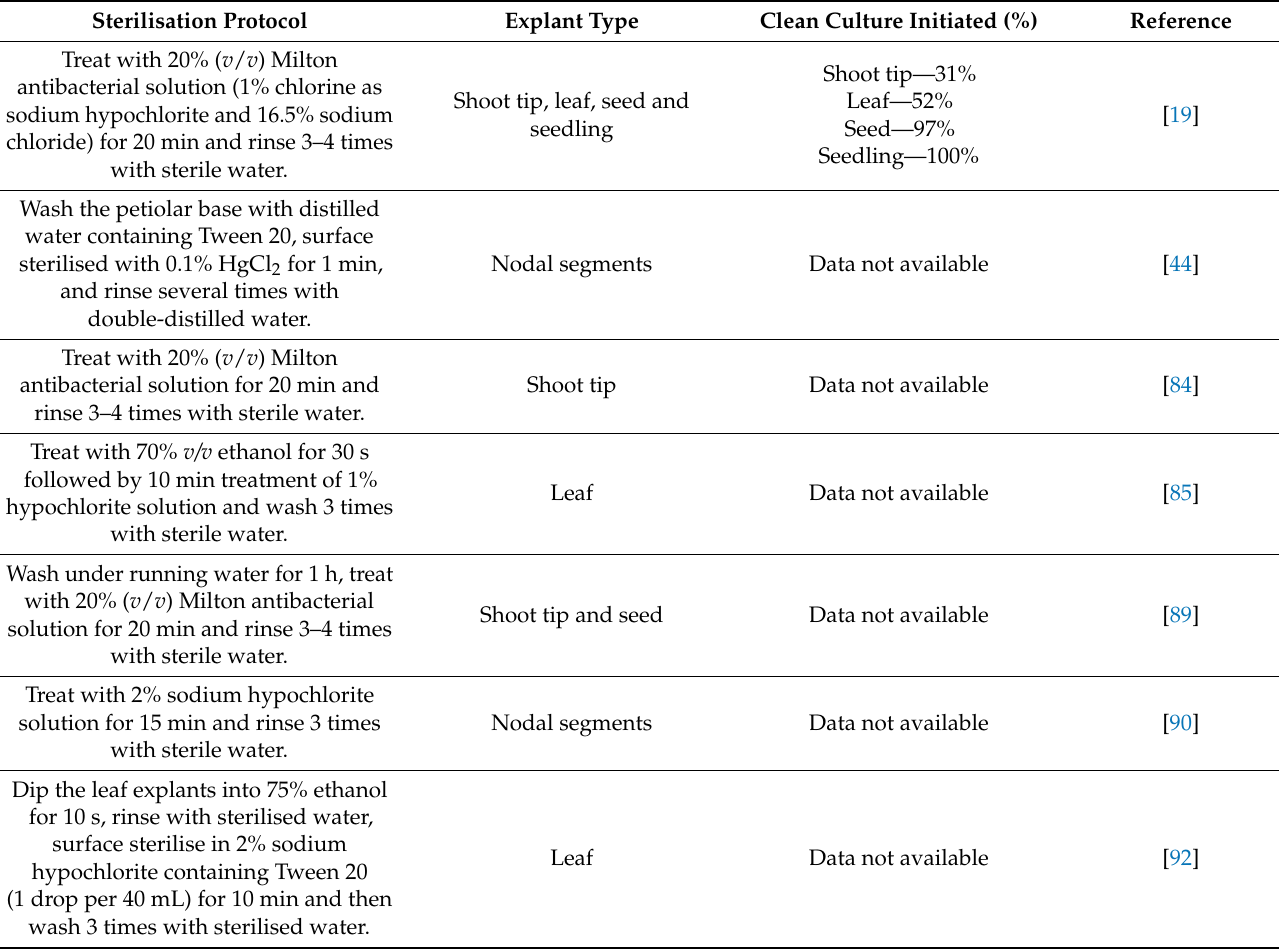
Table 1. Summary of sterilisation protocols for Duboisia culture